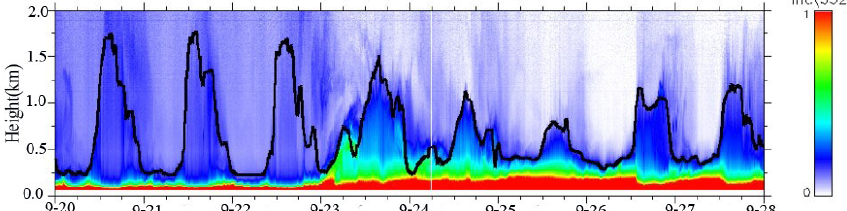
Fig. 7. Time-height indications of the normalized LIDAR backscatter signal in arbitrary units at 532nm. The black line is the height of the PBL.